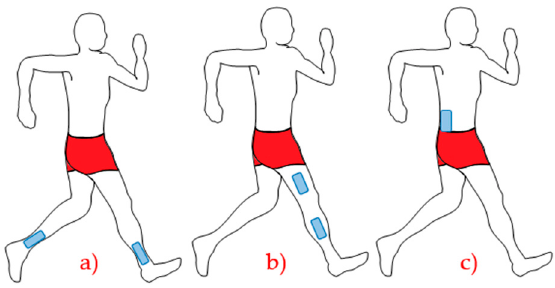
Figure 3. Examples of places to install smart sensors: ( a ) ankle; ( b ) thigh and tibia; and ( c ) lumbar.